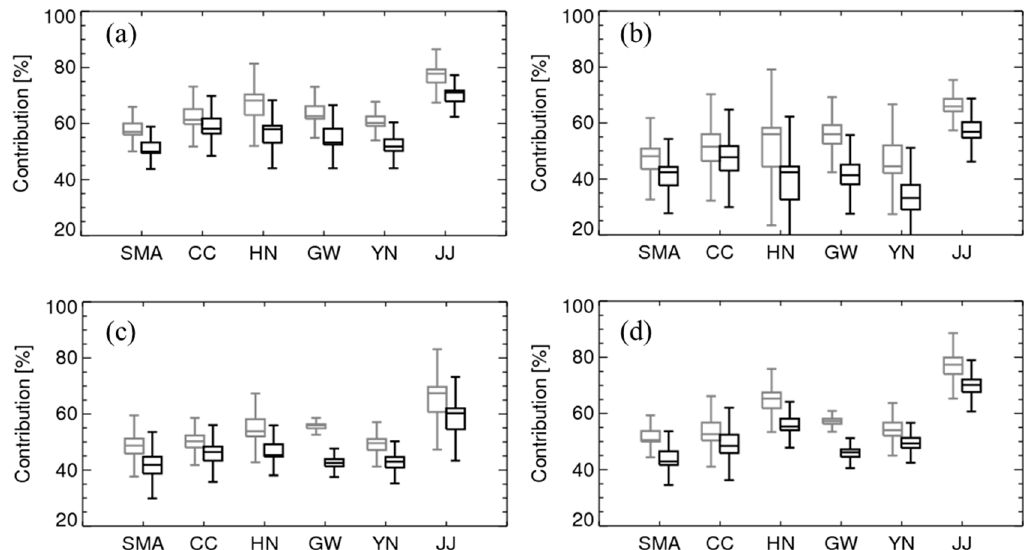
Figure 8. Variations in the Chinese contribution to seasonal mean PM 2.5 concentrations in the high-tier government boundaries in South Korea from 2010 to 2017 estimated via the 9-km simulation: ( a ) spring (March–May), ( b ) summer (June–August), ( c ) autumn (September–November), and ( d ) winter (December–February). The gray and black boxes represent the area-based and the monitor location-based Chinese contribution, respectively.